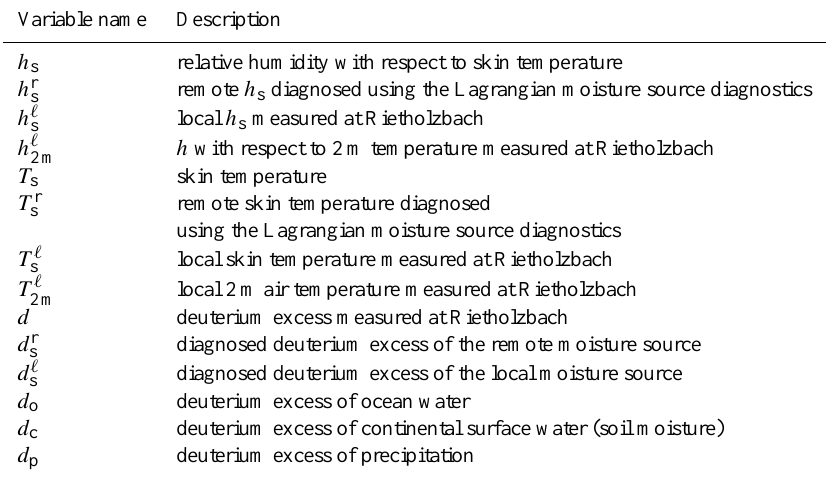
Table 2. Description of variable names used in the